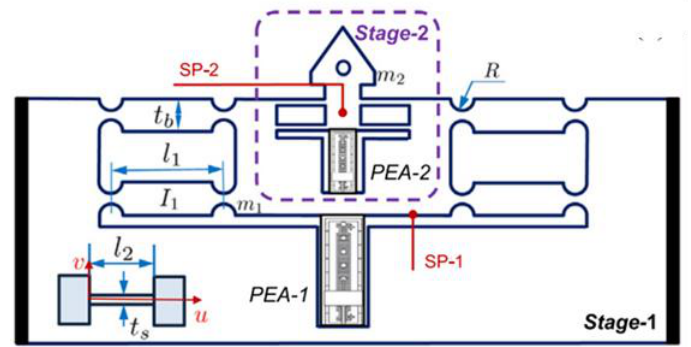
Figure 16. One degree of freedom (1 DOF) dual staged, dual actuator type FTS [120].